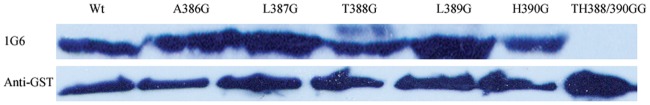
Western blot of 1G6 binding to rED3 with different mutations.Simultaneous mutations of T388 and H390 abrogated the binding of 1G6 to rED3.